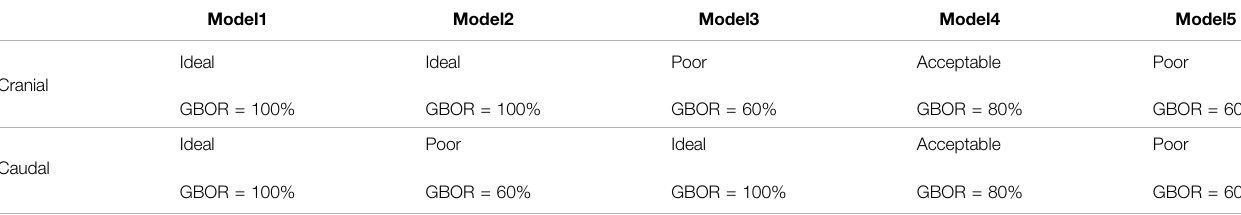
TABLE 1 | Construction of numerical models with different grades of contact suf fi